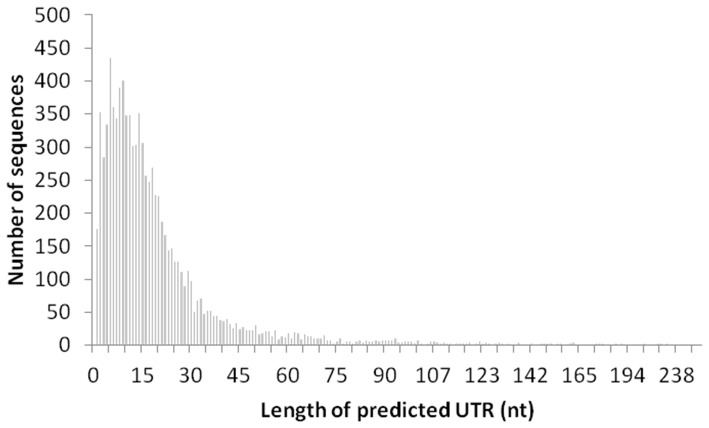
The length distribution of 5′-UTRs of Eutreptiella sp. cDNAs.The left skewed distribution pattern indicates high proportion of cDNAs with short 5′-UTRs.